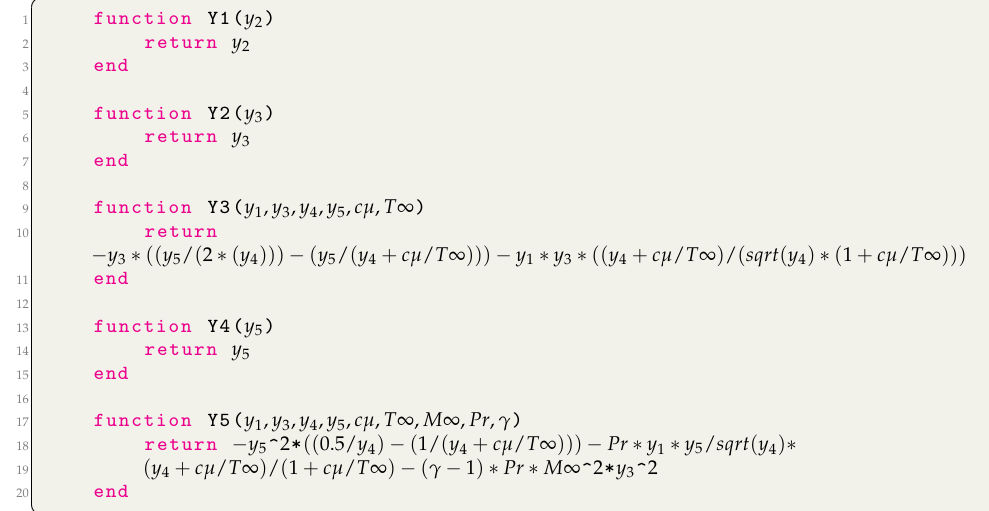
Listing 1. Implementation of system of equations in Julia environment. There are five functions which correspond to five first-order ordinary differential equations.